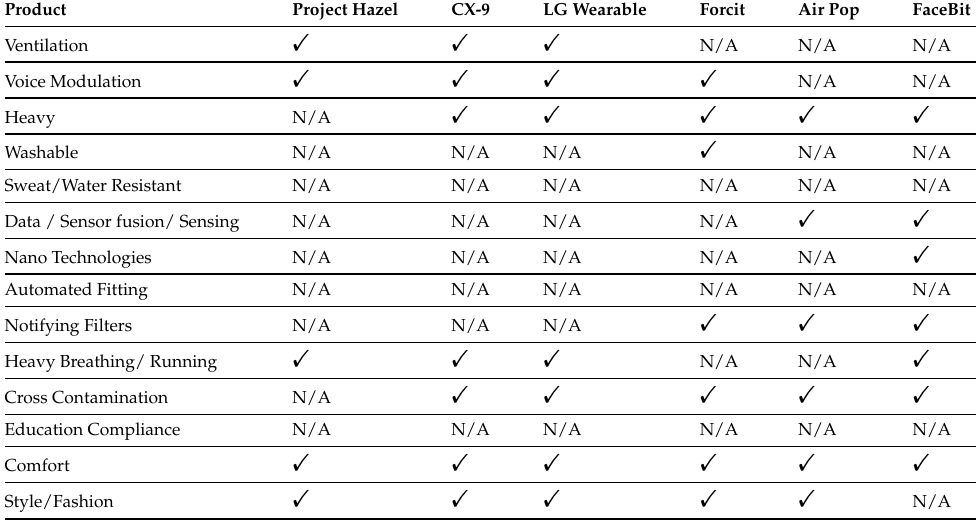
Table 1. Comparison of smart masks, their sensors, main focuses, and